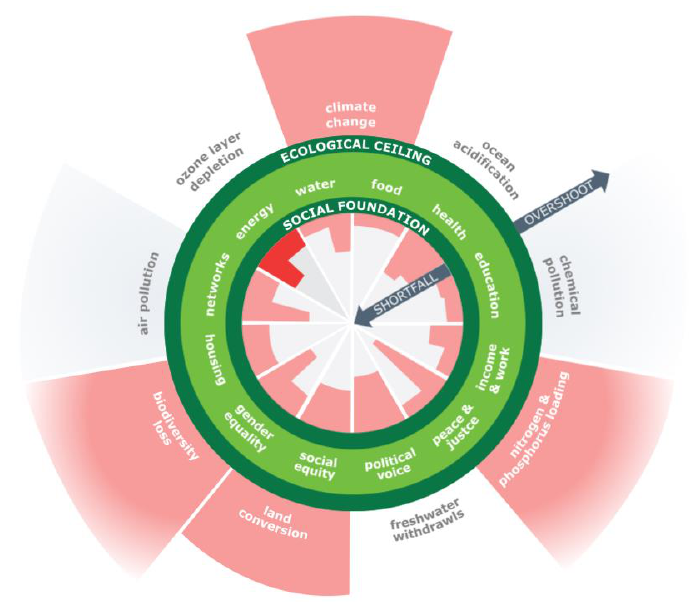
Figure 2: Fundamentals of Circular